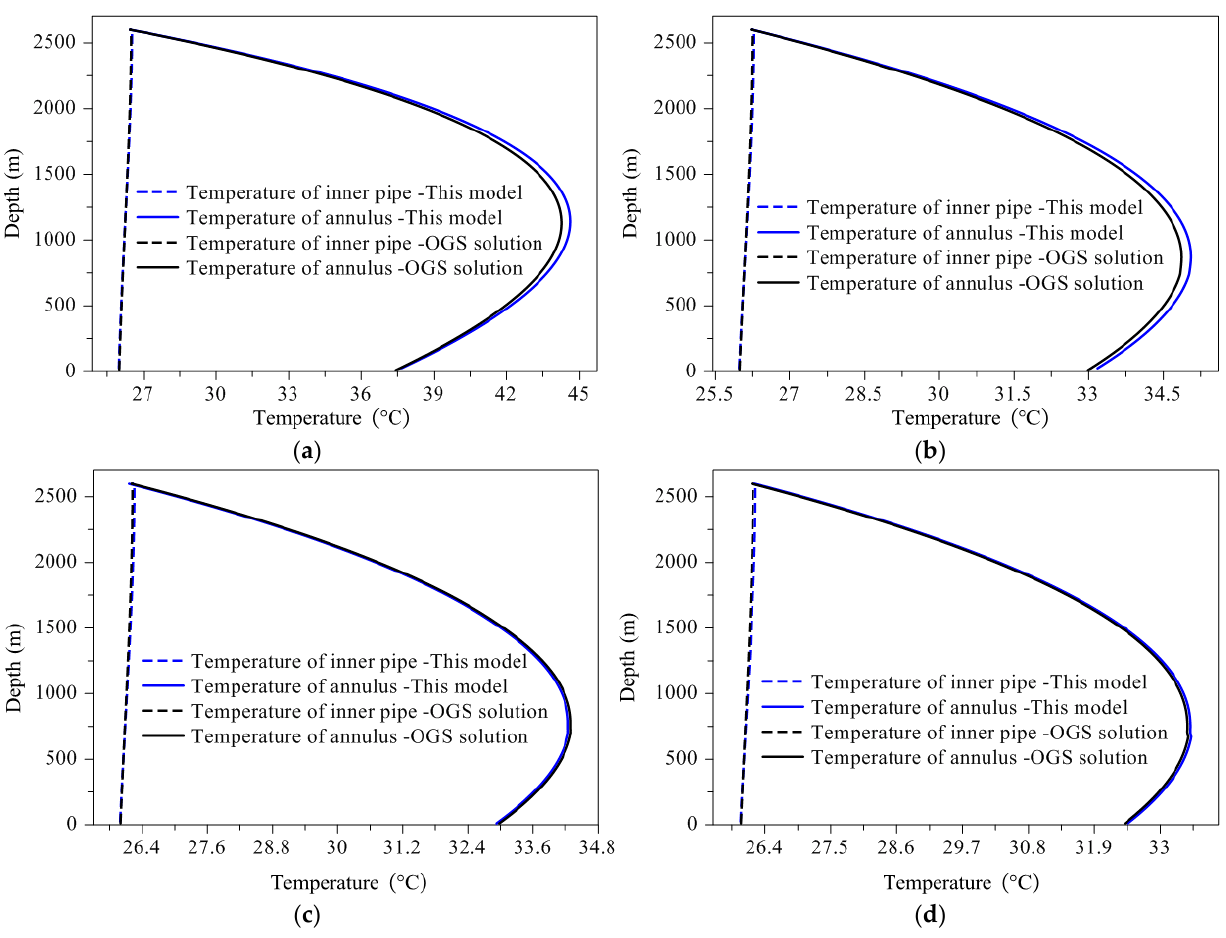
Figure 9. Comparison of simulation results of circulating fluid temperature profiles along depth in the annulus and inner column of DBHE during the low temperature heat storage days ( a )-1 day, ( b )-10 day, ( c )-20 day, ( d )-30 day.